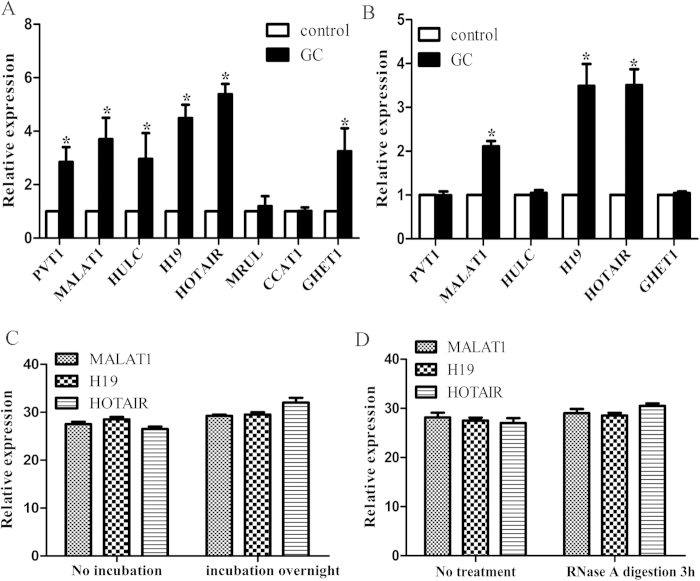
Validation of GC-related lncRNAs expression as circulating biomarkers.(A) The expression of lncRNAs in GC tissues. Differential expressions of lncRNAs in GC tissues were compared with those of normal tissues. (B) The expression of lncRNAs in GC plasma. Differential expressions of lncRNAs in GC plasma were compared with those of normal plasma. (C) LncRNAs expression with prolonged room temperature incubation time. (D) LncRNAs expression with RNase A digestion. (*P < 0.05, compared with control tissues).